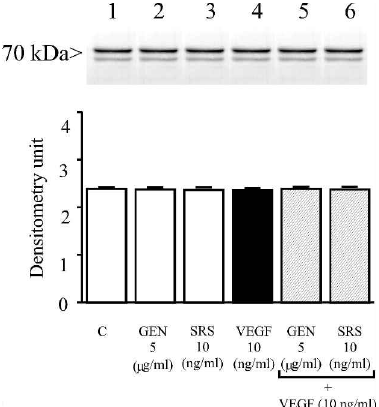
FIG. 6. The effects of genistein (GEN) and staurosporine (SRS) on COX-1 expressed in VEGF-treated HUVEC. COX-1 was detected by Western blots using specific antibodies to COX-1 in cell extracts of HUVEC treated with no addition (lane 1), with genistein (5 m g/ml) alone (lane 2), with staur- osporine (10ng/ml) alone (lane 3), with VEGF (10ng/ml) alone (lane 4), with VEGF (10ng/ml) + genistein (5 m g/ml; lane 5) or with VEGF (10ng/ml) + staurosporine (10ng/ml; lane 6) for 24h. Equal amounts of protein (20 m g/lane) were loaded in each lane. Similar results were obtained with cell extracts from three separate batches of cells. The significant differ- ences between each band were compared by scanner densitometry using an image one-dimensional program (densitometry